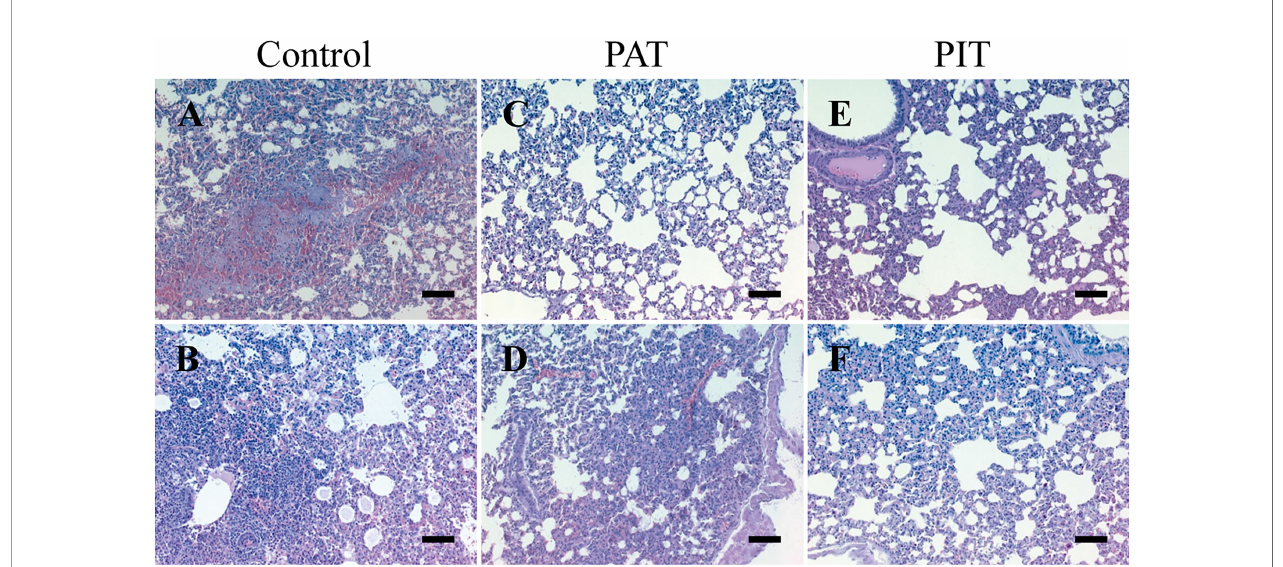
FIGURE 6 | Histopathological fi ndings in the lungs of hamsters challenged with SARS-CoV-2. (A) Areas of necrosis with hemorrhage, thickened alveolar wall, and in fi ltration mononucleated in fl ammatory cells (B) Invasion of intraalveolar mononuclear in fl ammatory cells (C) No visible lesions (D) The pulmonary parenchyma appears thickened in some areas with atelectasis, the alveoli are clean, there is no in fi ltration of in fl ammatory cells (E) Slightly thickened pulmonary parenchyma, the alveoli slightly dilated, but without in fi ltration of in fl ammatory cells (F) Thickening of the alveolar wall, the alveolar lumen does not present cellular in fi ltration. Image amplitude: 20x. Scalebars: 200